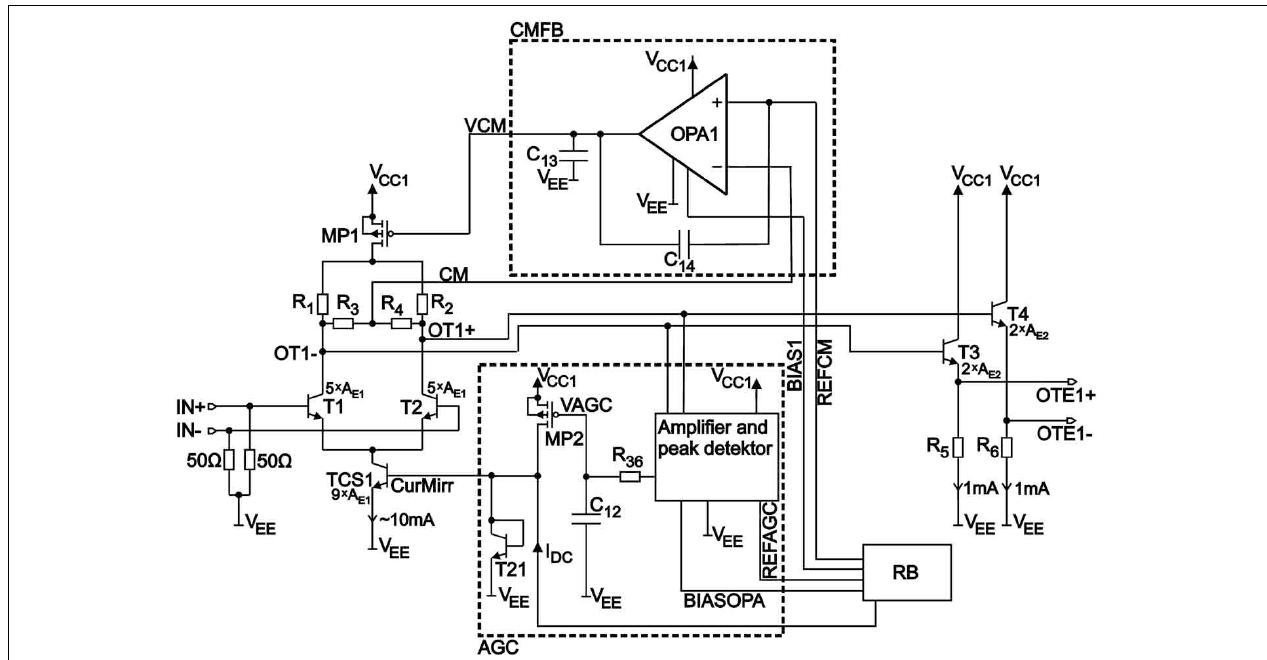
FIGURE 3 | Schematic of the pre-amplifier of modulator driver variant one and variant two (AGC, Automatic Gain Control; CMFB, Common-Mode Feedback). The emitter areas are A E1 = 0 . 353 µ m 2 and A E2 = 0 . 493 µ m 2